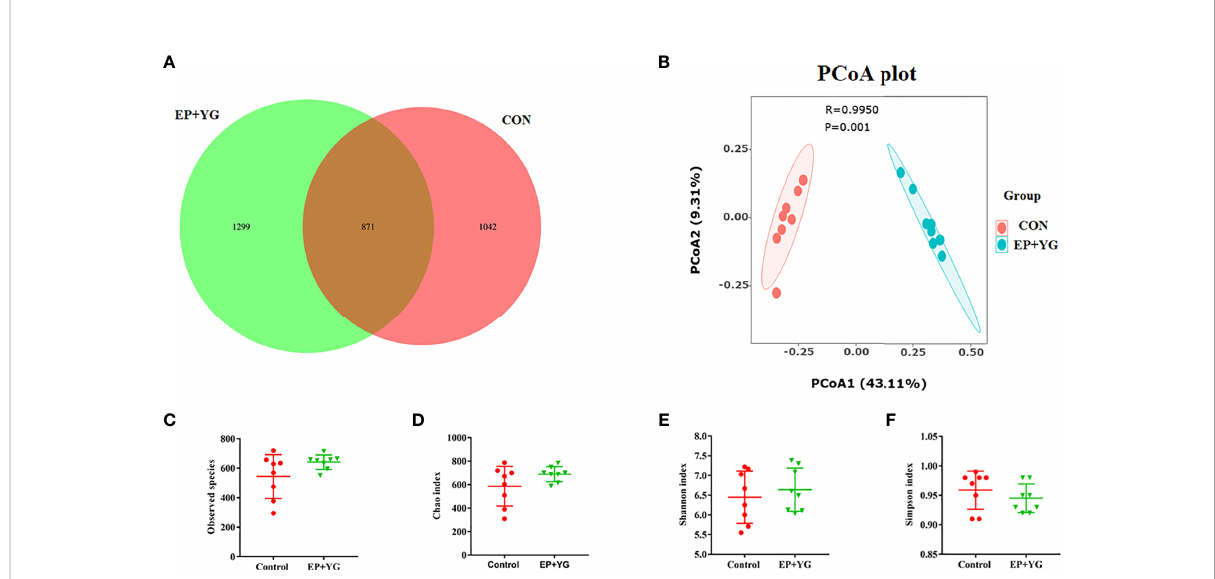
FIGURE 3 The Venn diagram, alpha and beta diversity analysis of caecal microbiota of treatment and control group chickens (n=8). (A) Venn diagram shows the unique and shared OTUs between treatment groups; (B) principal coordinate analysis (PCoA) generated using Bray-Curtis dissimilarity approach (C) observed species, (D) Chao index, (E) Shannon index, (F) Simpson index. Statistical signi fi cance was assessed using the Kruskal- Wallis test. CON (fed basal diet); EP+YG (supplemented with 200 mg EP and 200 mg YG/kg diet in combination).